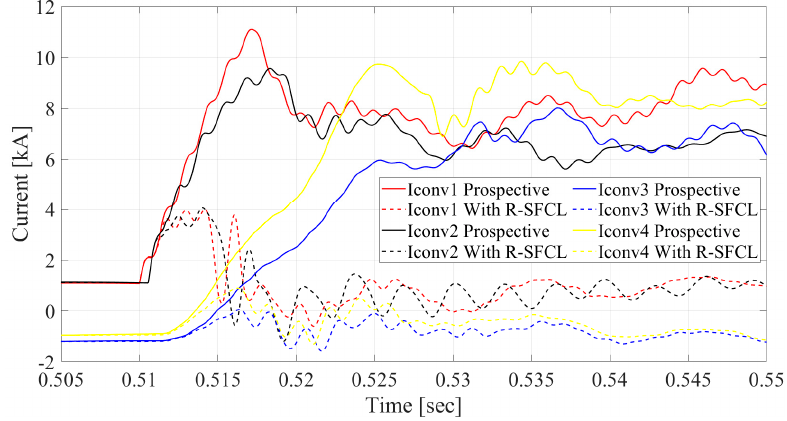
Figure 19. Converter’s fault currents with and without current limiter under pole-to-pole fault condition. Table 5. Peak current and limiting factor comparison for pole-to-pole fault.